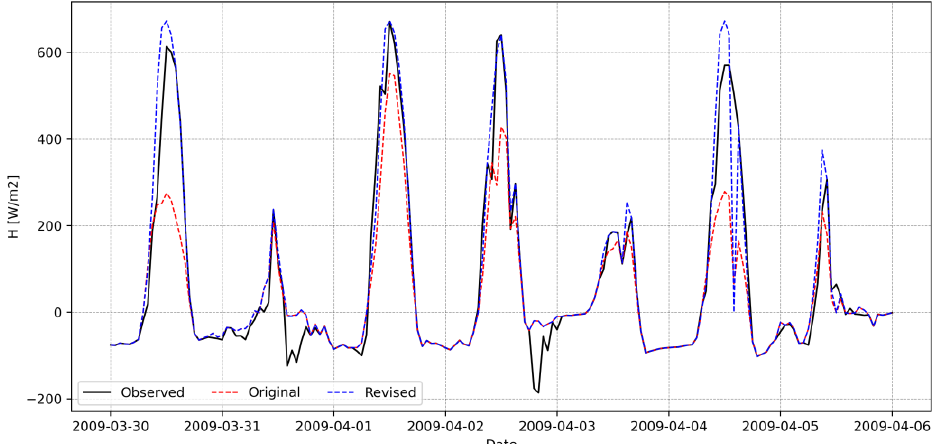
Figure 6. Variations in the observed and simulated sensible heat flux by the original and the revised parameterization at 30 min temporal resolution over five days at the US-MMS site.